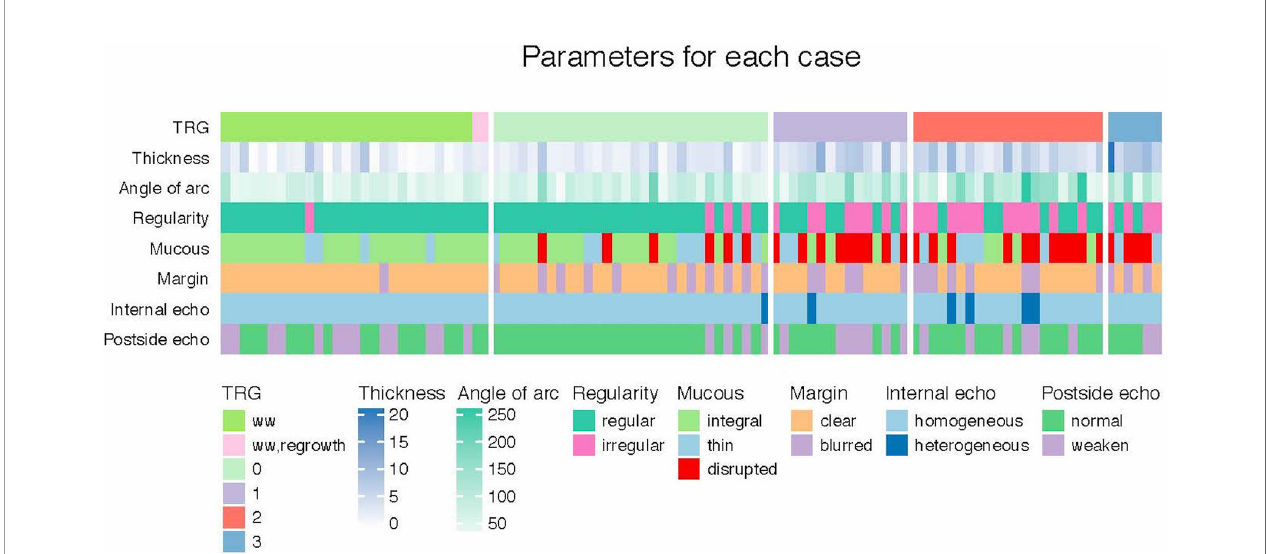
FIGURE 3 | Data distributions of the main three-dimensional transrectal ultrasound (3D-TRUS)